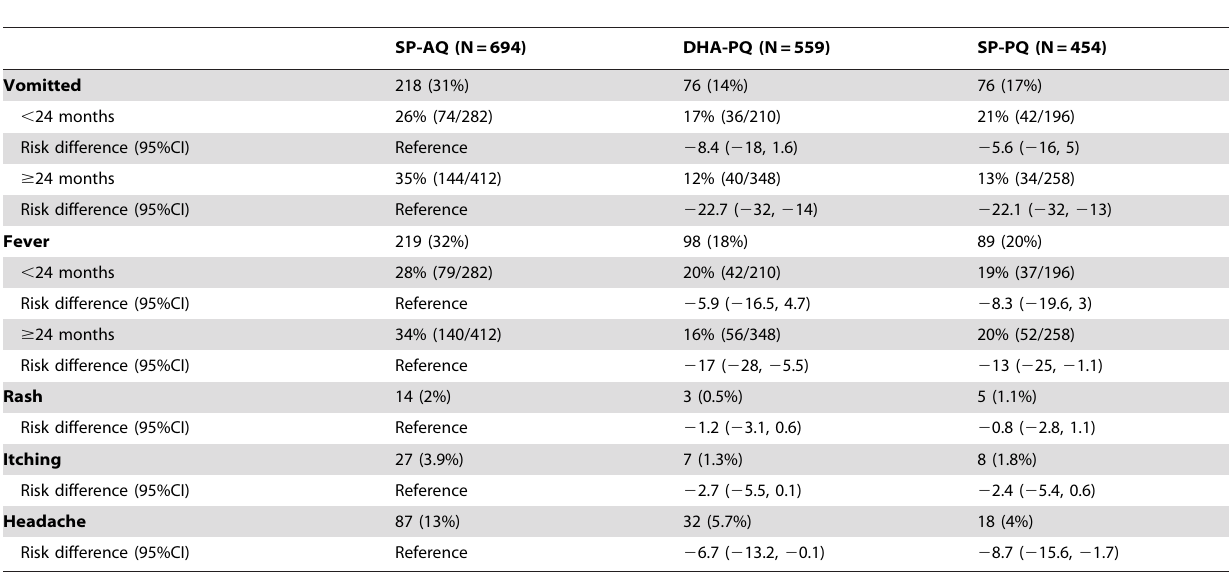
Table 4. Incidence of solicited adverse events reported by mother or carer four days day after the first administration of